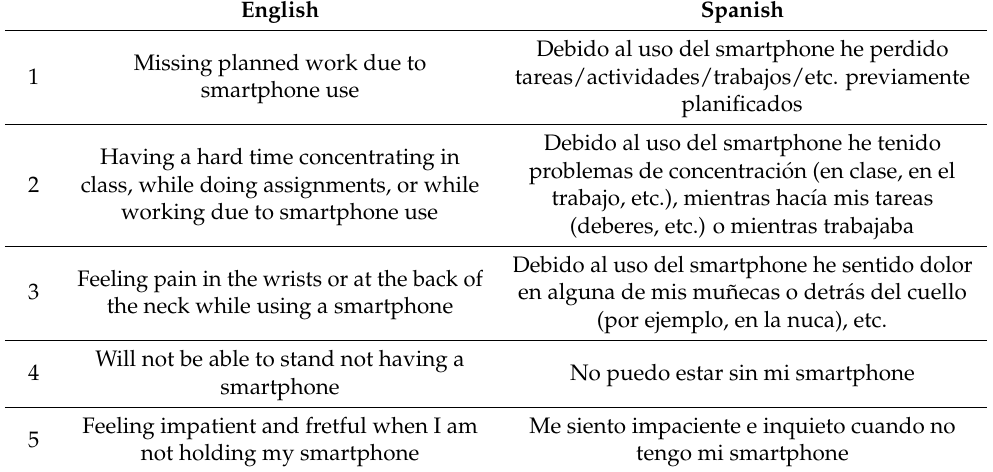
Table A1. Complete list of the items in English and Spanish of the Smartphone Addiction Scale Short Version